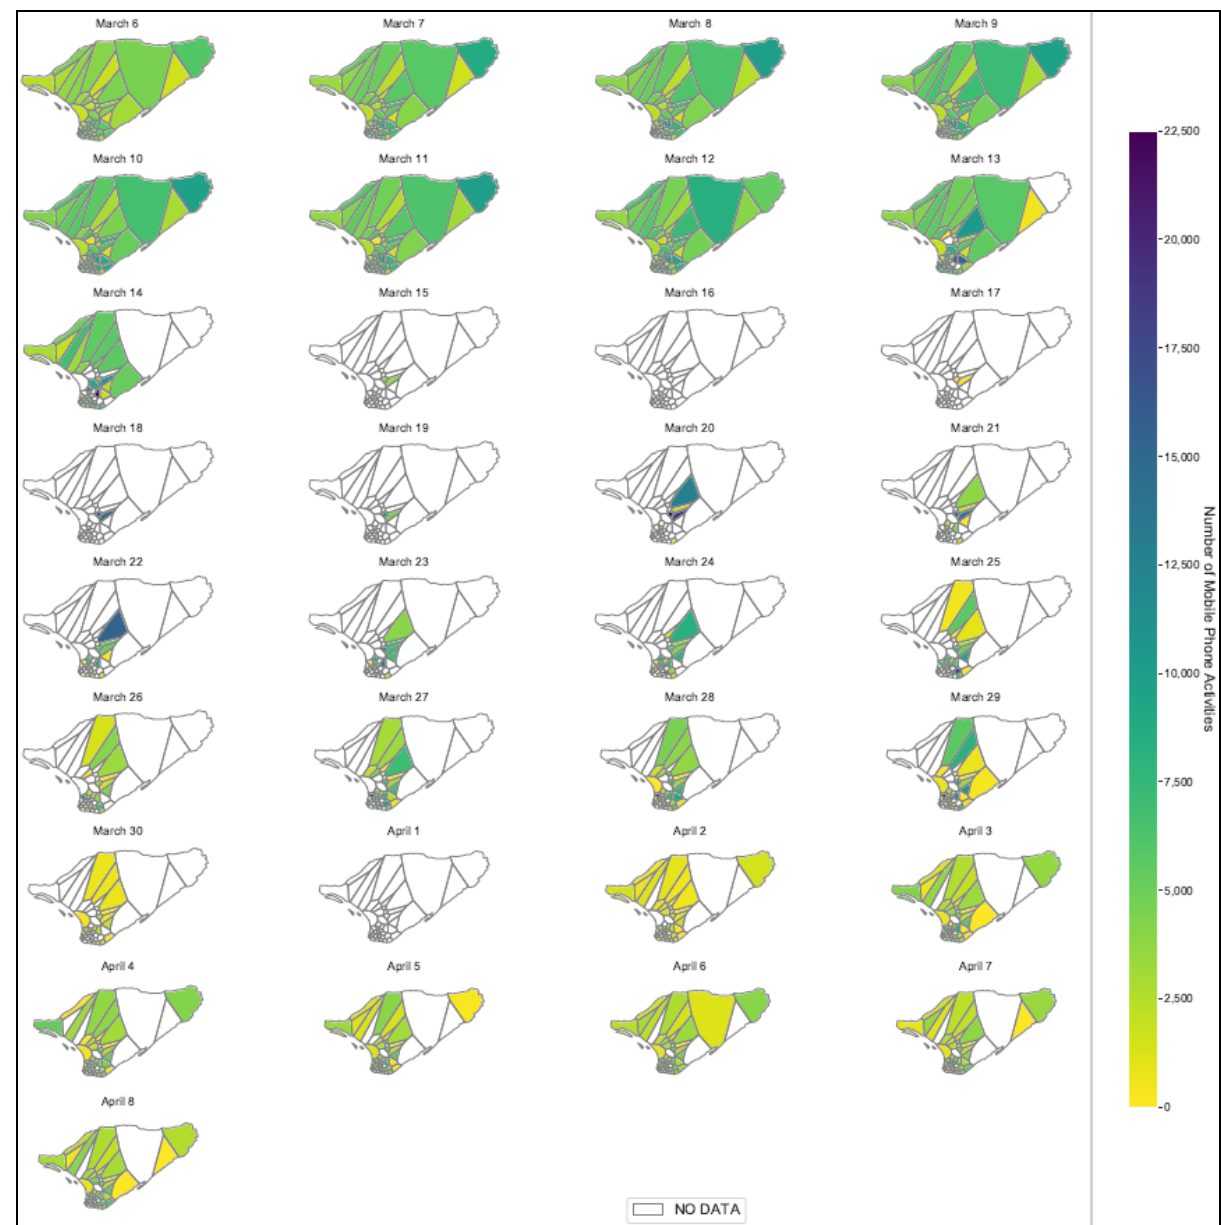
Figure 7. Daily Distribution of Mobile Phone Activities per